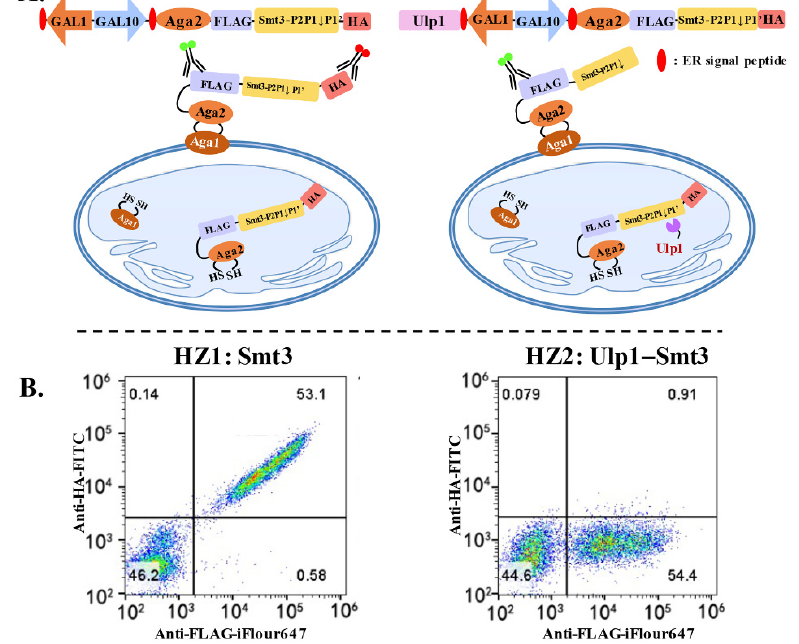
Figure 1. YESS–PSSC system for quantitatively characterizing Ulp1–Smt3 specificity. ( A ) Scheme of YESS–PSSC system for substrate specificity analysis of Ulp1 against Smt3. Left: represents cells merely expressing substrate part (Aga2-FLAG-Smt3-HA). Right: represents cells simultaneously expressing Ulp1 and substrate part (Aga2-FLAG-Smt3-HA). ( B ) Flow cytometry analysis that characterizes Ulp1–Smt3 specificity in YESS–PSSC system. Left: HZ1 corresponded to the result of ( A ) left. Right: HZ2 corresponded to the result of ( A ) right.